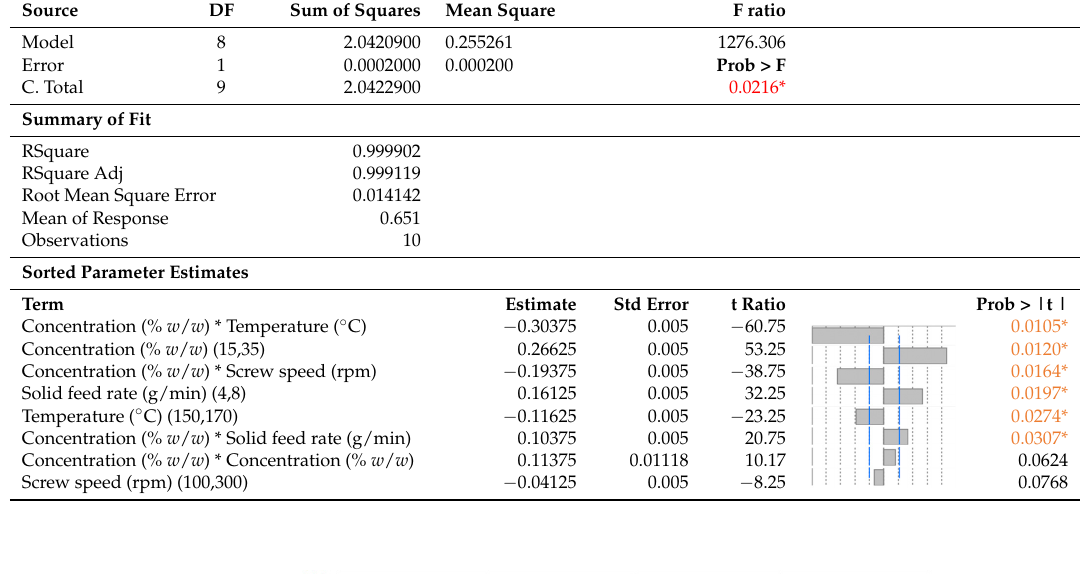
Table 3. Analysis of variance for response Abs at 680 nm (DoE1).